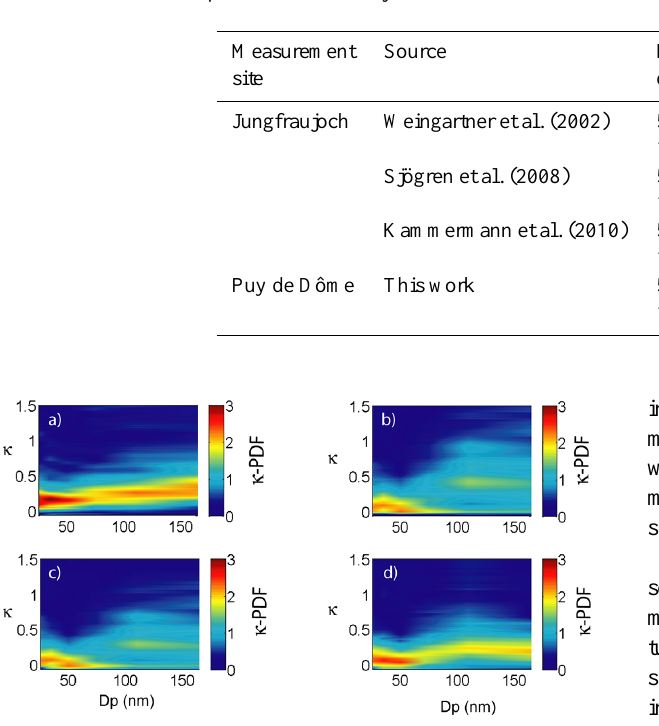
Table 2. Average growth factors measured at RH90 at the Jungfraujoch site and at the Puy de Dôme. Yearly average values for the Puy de Dôme includes the complete measurement years 2011–2012.